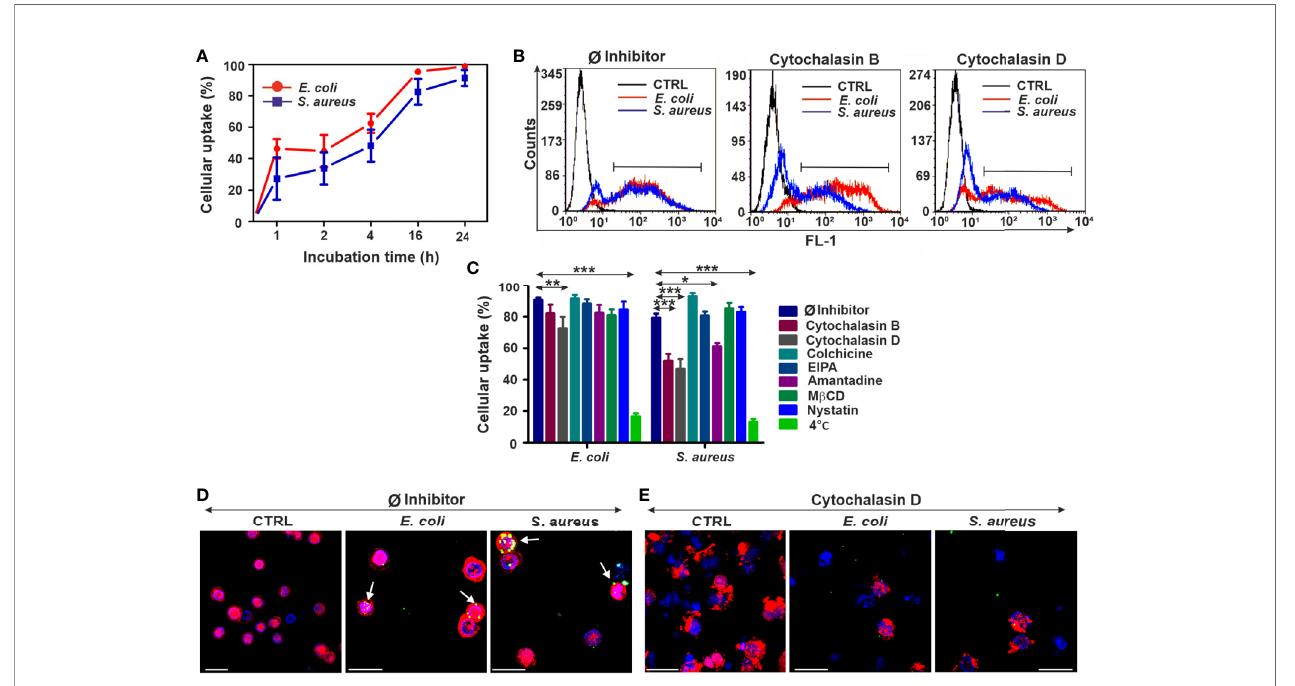
FIGURE 1 | The upshots of endocytosis inhibition on the bacterial uptake in THP-1 cells. (A) Kinetics of FITC- E. coli and FITC- S. aureus bacteria uptake by THP-1 cells after 1, 2, 4, 16, and 24 h of incubation. (B) Representative fl ow cytometry histograms of THP-1 cells after 24 h of bacteria engulfment without or with inhibitors (5 µM cytochalasin B/cytochalasin D). (C) Ef fi ciency of different endocytosis inhibitors on the bacterial uptake of THP-1 cells. The results are presented as mean ± SD of four replicates. Asterisks denote statistical signi fi cance (* p < 0.05, ** p < 0.01, *** p < 0.001) between the Ø inhibitor control and different treatments. (D) Merged CLSM images of THP-1 cells incubated in the absence of inhibitors and (E) in the presence of 5 µM cytochalasin D that demonstrate the changes in the actin cytoskeleton (red, CF568 Phalloidin) and inhibition of bacterial (green, FITC- E. coli and FITC- S. aureus ) uptake. Nuclear counterstaining was performed with DAPI (blue). Note the overlapping signal between engulfed bacteria and actin fi laments (arrows, D ). Scale bars: 50